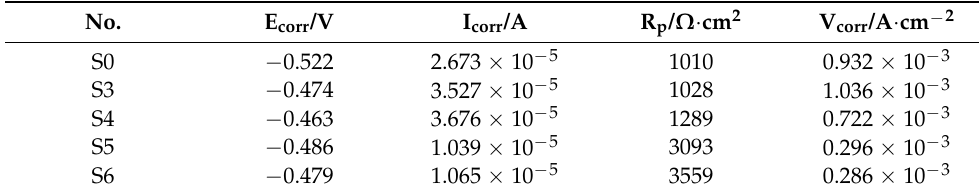
Figure 11. Potentiodynamic polarization curves and Nyquist plots of composite coating with different ceramic micro-particles. ( a ) Potentiodynamic polarization curves; ( b ) Nyquist plots. Table 2. Potentiodynamic polarization test results in Figure 11.